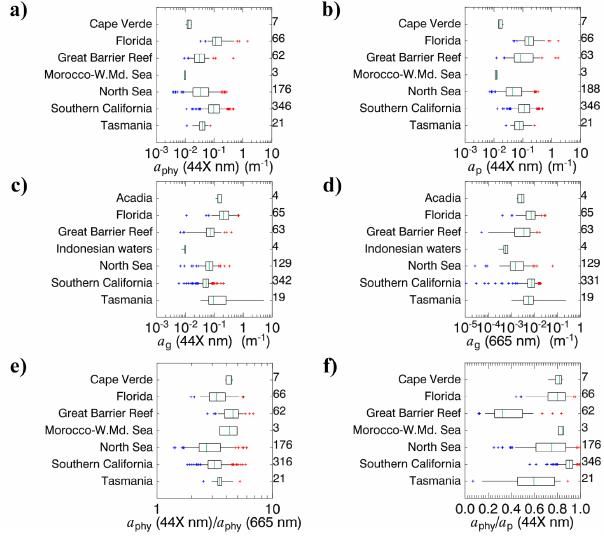
Figure 15. The distributions of (a) a phy (44X), (b) a p (44X), (c) a g (44X), (d) a g (665), (e) the ratios a phy (44X) /a phy (665), and (f) a phy /a p (443) measured at the CoastColour sites. When coeffi- cients at wavelength 443nm are missing, they are replaced by data at 440 or 442nm. The graphical convention is identical to Fig.